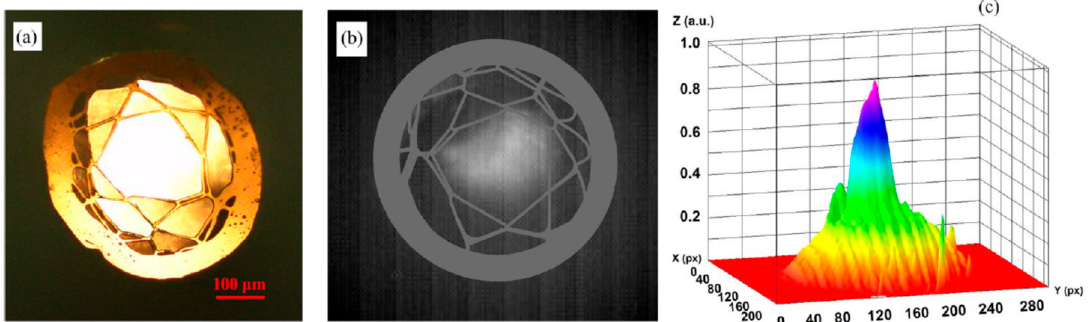
Figure 15. ( a ) Hollow-core fiber cross-section under an optical microscope operating in the visible, ( b ) mid-IR mode image, and ( c ) intensity profile. Reproduced with permission from [107].